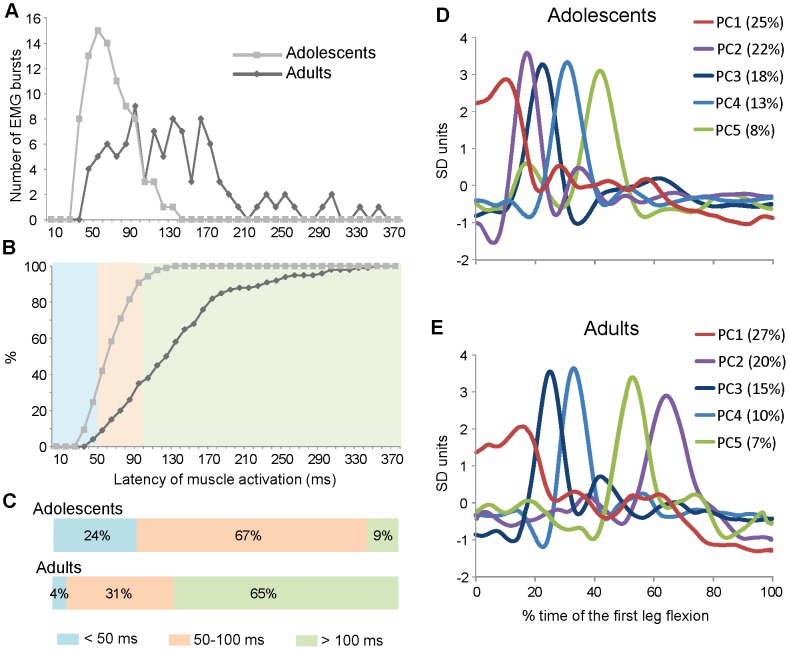
EMG latency distributions and Principal Components Analysis.Distribution of EMG latency (A–C) and principal components waveforms (D–E) over the interval of the first flexion. The EMG latency was measured from the onset of the leg fall and it is represented as distribution (A) and cumulative (B) frequency histograms. The latency distributions were parceled in three bands and expressed as fractions of the total measurements (C). Principal components analysis was performed on the two datasets of EMG responses recorded in adolescents (D) and in adults (E) with Down syndrome. The first five components accounted for 86% of the total variance in the adolescents and for 79% in the adults. For each component is reported the fraction of variance accounted. The time base is expressed as percentage of the first flexion length.